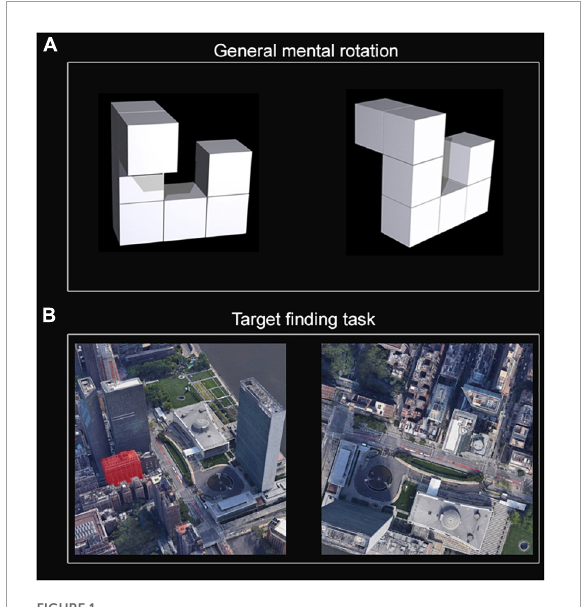
FIGURE1 Eye-tracking tasks. (A) General mental rotation (MR). (B) Target finding (TF) task.